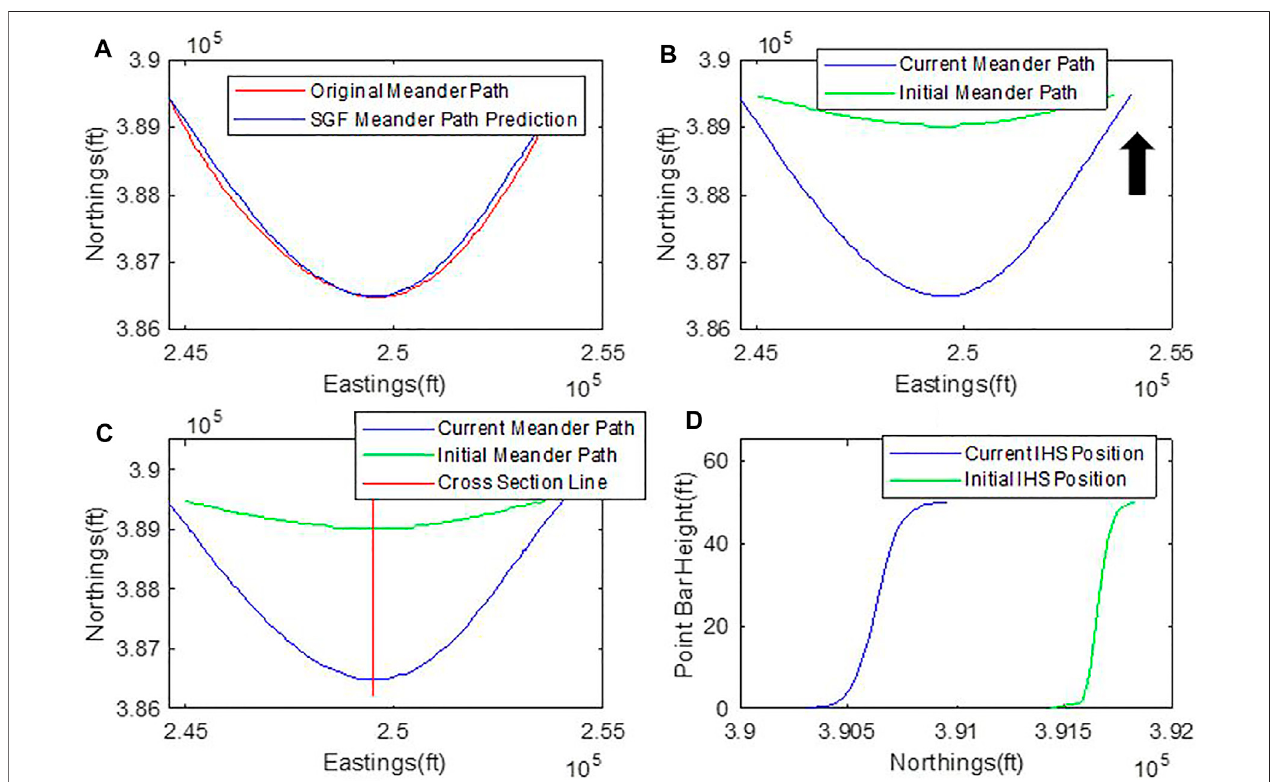
FIGURE4| Meandermigrationprocess. (A) IllustrationofclosematchbetweenSGFpredictionandtheoriginalmeanderpath, (B) Currentandinitialmeanderpath location after backward migration of channel (arrow indicates direction of backward migration, i.e., migration starting from today ’ s channel path to the ancient path), red line shows section across the meanders, and (D) IHS revealed along section in (C)